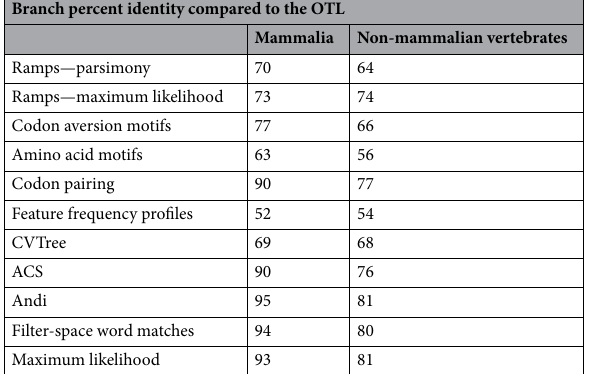
Table 2. Branch percent identities of phylogenies recovered using the presence/absence of ramp sequences or other genomic features compared to the OTL.